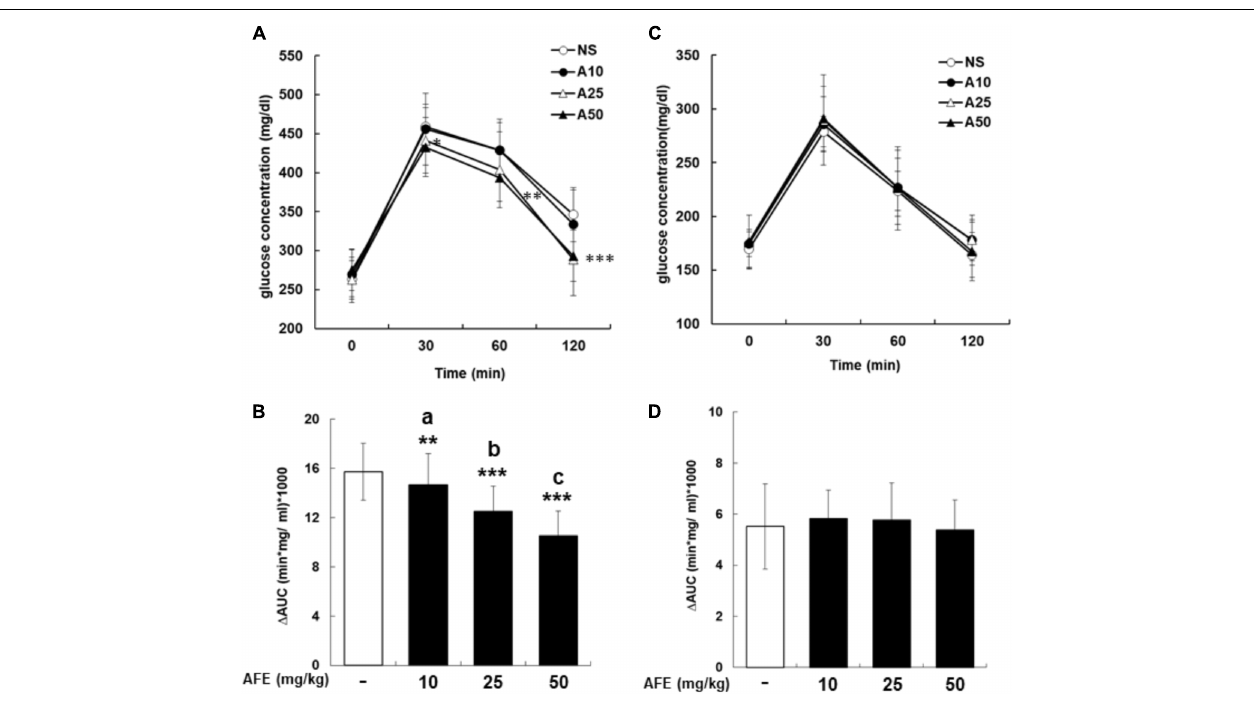
FIGURE 2 | Anoectochilus formosanus extract reduces blood glucose in hyperglycemic but not in control mice. Hyperglycemic mice were injected with different dosages of AFE intraperitoneally. Glucose was injected intraperitoneally immediately after AFE administration. Blood glucose was measured at 0, 30, 60, and 120 min after glucose administration. (A) The time courses of blood glucose concentration measured in fructose-induced hyperglycemic mice treated with different dosages of AFE (10 to 50 mg/kg). NS: treated with normal saline; A10: treated with AFE 10 mg/kg; A25: treated with AFE 25 mg/kg; A50: treated with AFE 50 mg/kg. Data are shown as mean ± SD ( n = 16). (B) Measurement of the area under the incremental blood glucose concentration curve in the glucose tolerance test of the experimental group mice. –: treated with normal saline as control; 10: treated with AFE 10 mg/kg; 25: treated with AFE 25 mg/kg; 50: treated with AFE 50 mg/kg. Data are shown as mean ± SD of each group of four animals random cross over four times, analysis by one-way ANOVA test. ∗∗ p < 0.01, ∗∗∗ p < 0.001 as compared with untreated control. a AFF 10 vs. 50 mg/kg, p < 0.001; b AFF 25 vs. 10 mg/kg, p < 0.05; c AFF 50 vs. 25 mg/kg, p < 0.05. Glucose was injected intraperitoneally after AFE administration in non-hyperglycemic mice. Blood glucose was measured at 0, 30, 60, and 120 min after glucose administration. (C) Time courses of blood glucose concentration measured in non-hyperglycemic mice treated with different dosages of AFE (10 to 50 mg/kg). NS: normal saline; A10: treated with AFE 10 mg/kg; A25: treated with AFE 25 mg/kg; A50: treated with AFE 50 mg/kg. Data are shown as mean ± SD ( n = 8). (D) Measurement of the area under the incremental blood glucose concentration curve in the glucose tolerance test of non-hyperglycemic mice. –: treated with normal saline as control; 10: treated with AFE 10 mg/kg; 25: treated with AFE 25 mg/kg; 50: treated with AFE 50 mg/kg. Data are shown as mean ± SD, analysis by one-way ANOVA test ( n = 8).